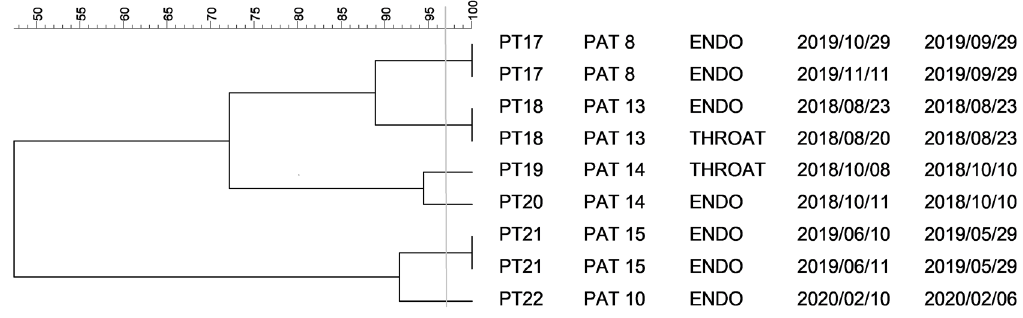
Figure 2. Dendrogram for restriction patterns of K. variicola isolates. Legend: horizontal axis—similarity of isolates (%); vertical axis—pulsotype, patient code, type of sample, date of sample collection, date of VAP diagnosis; PT pulsotype, PAT patient, ENDO endotracheal aspirate sample, THROAT throat swab. The vertical line indicates the similarity threshold set at 97%.